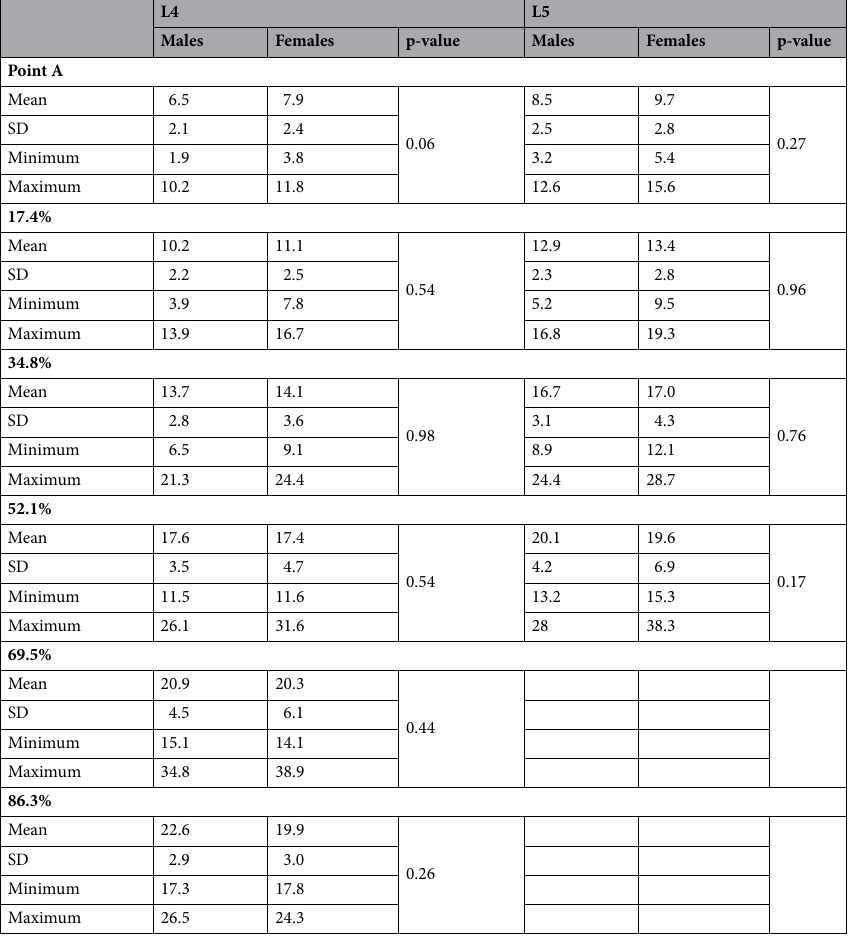
Table 2. Sex differences of intervals between the ventral branches of L4/L5 and respective measurements points (Point A on the linea terminalis and 17.4%/34.8%/52.1%/69.5%/86.3% of the total length of the sacro- iliac joint). Data are presented in